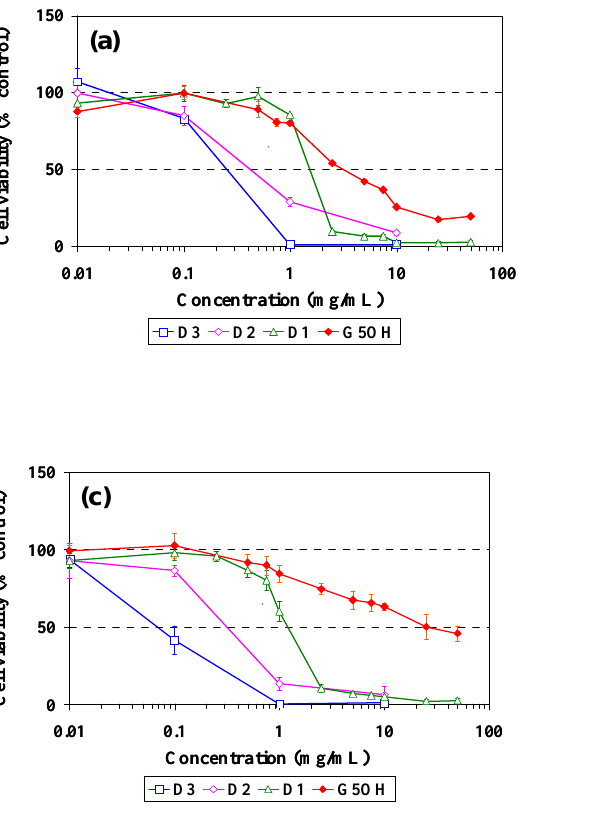
Figure 4. Cell viability curves of dendrimers in tissue culture cell lines: (a) Dodecyl modified dendrimers in PLE cells (b) Cholesteryl modified dendrimers in PLE cells (c) Dodecyl modified dendrimers in CHO cells (d) Cholesteryl modified dendrimers in CHO